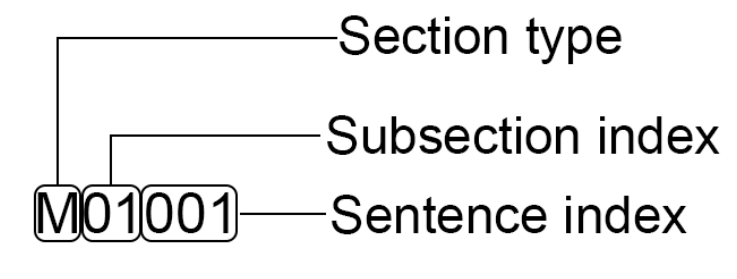
Figure 5. An example of sentence ID. The ID refers to the second sentence in the second subsection of the method section. Indexes start with